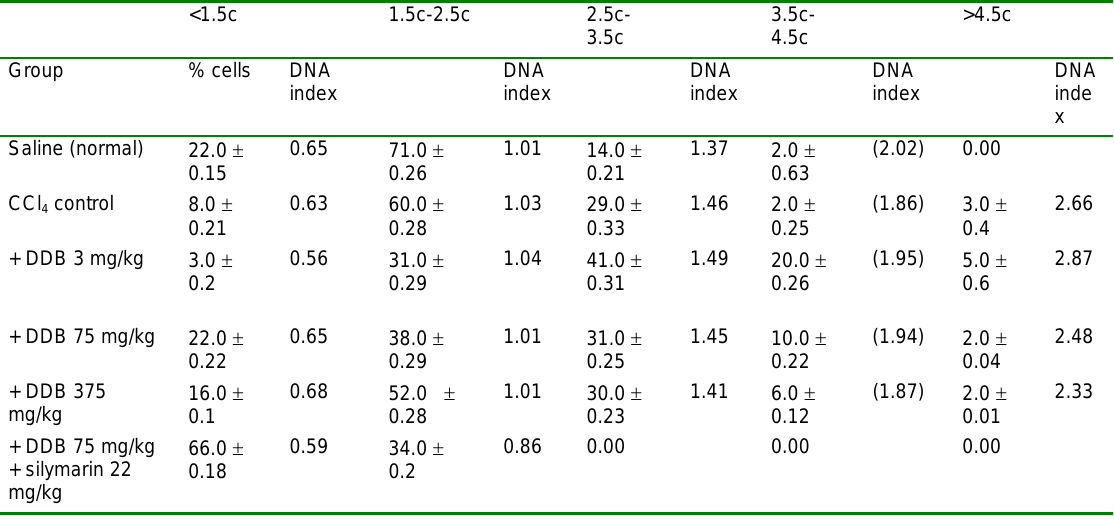
, silymarin, DDB or DDB + 4